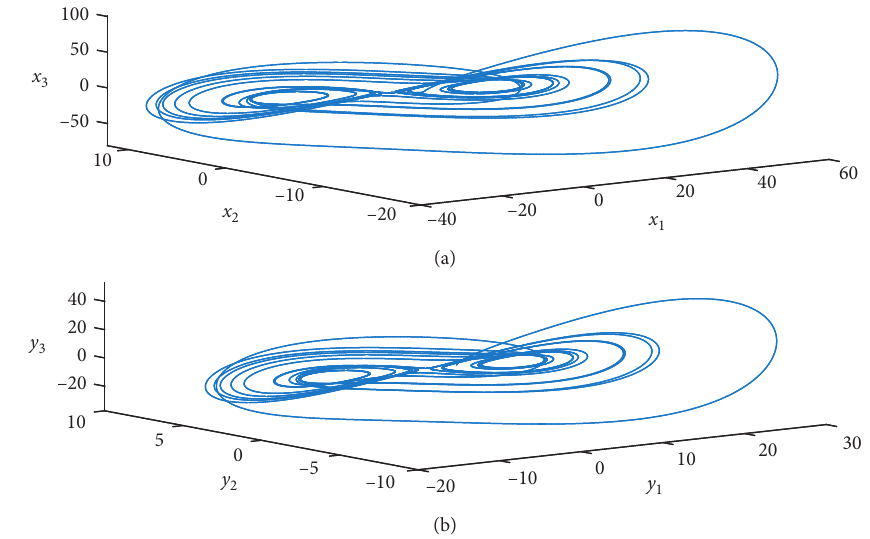
Figure 10: The phase portrait of master subsystem and the slave subsystem.